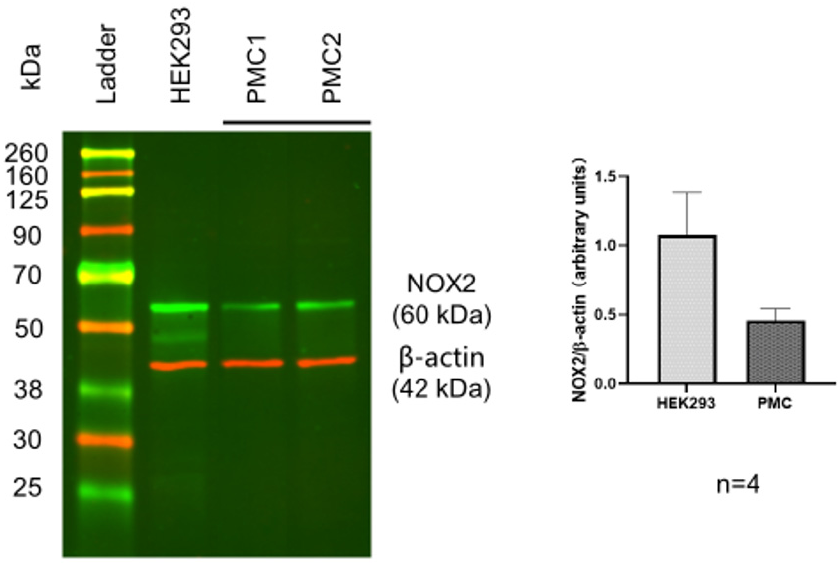
Figure 2. Western blot of Nox-2 in PMC from the mouse brain. HEK293 served as a positive control. Data show positive expression of Nox-2 in PMC, comparable to that in HEK293 cells.